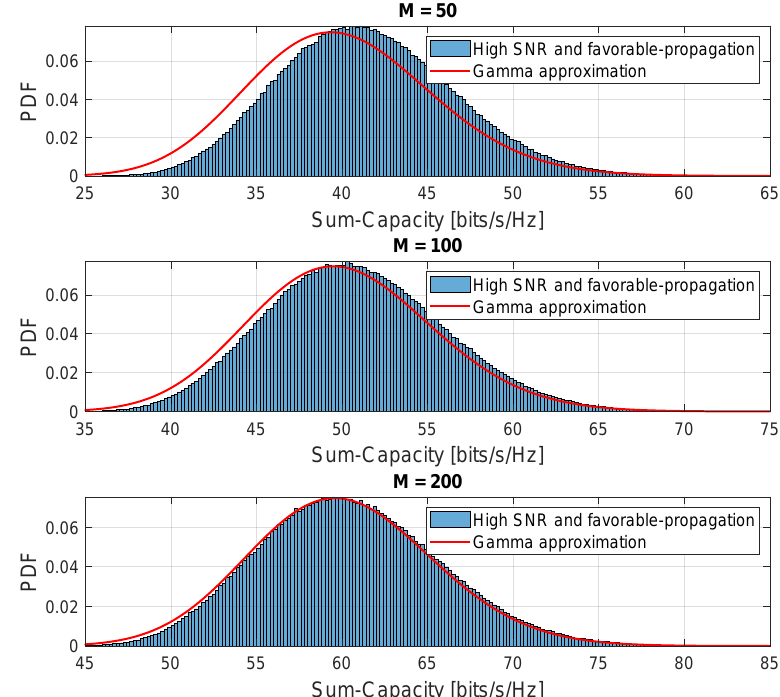
Figure 8. Comparison of the approximated PDF for the instantaneous sum-capacity in the high-SNR regime and favorable propagation condition.